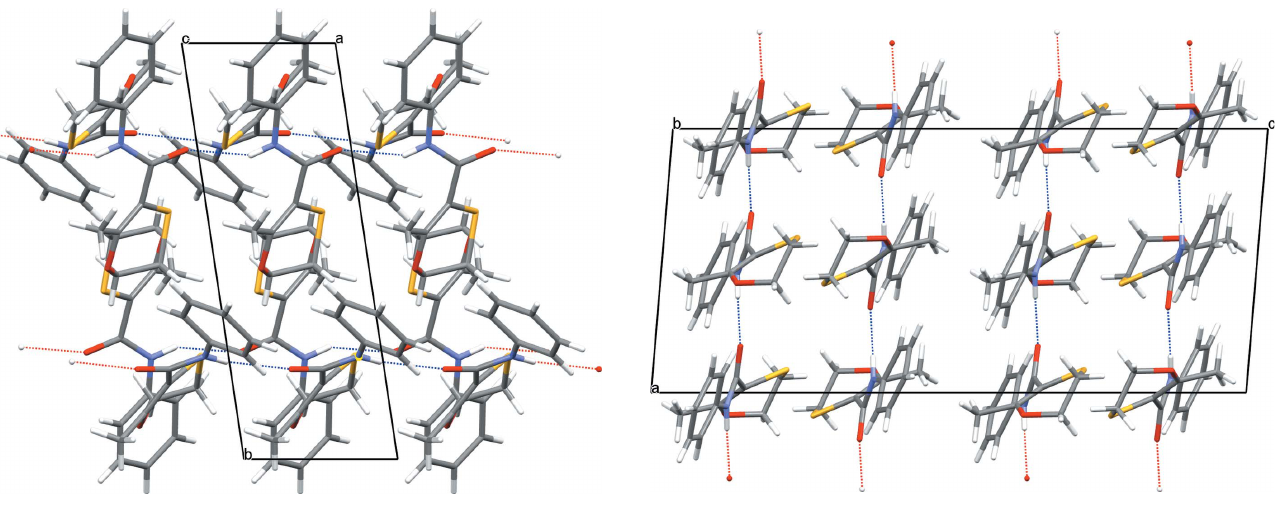
Figure 7 View of the crystal packing of form 2 as viewed down the b axis. The N— H (cid:2)(cid:2)(cid:2) O hydrogen bonds are shown as dotted lines (see Table 2 and text).